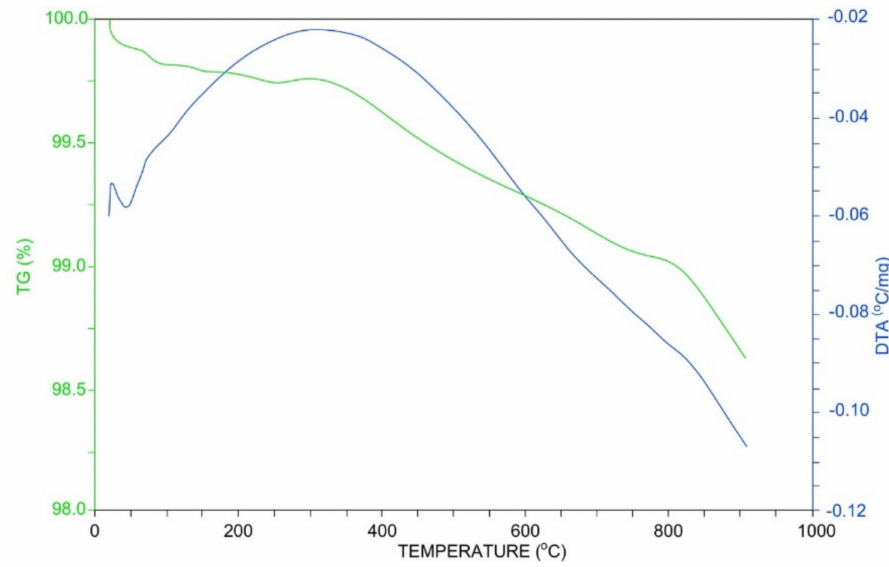
Figure 2. TG-DTA curves of